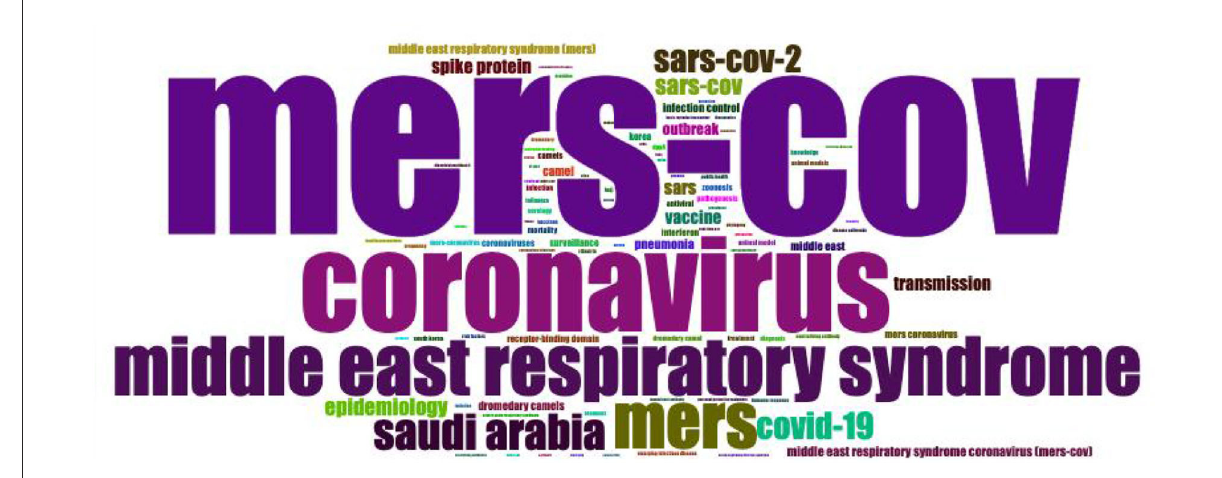
FIGURE7 A WordCloud map of frequently used top 100 author’s keywords.